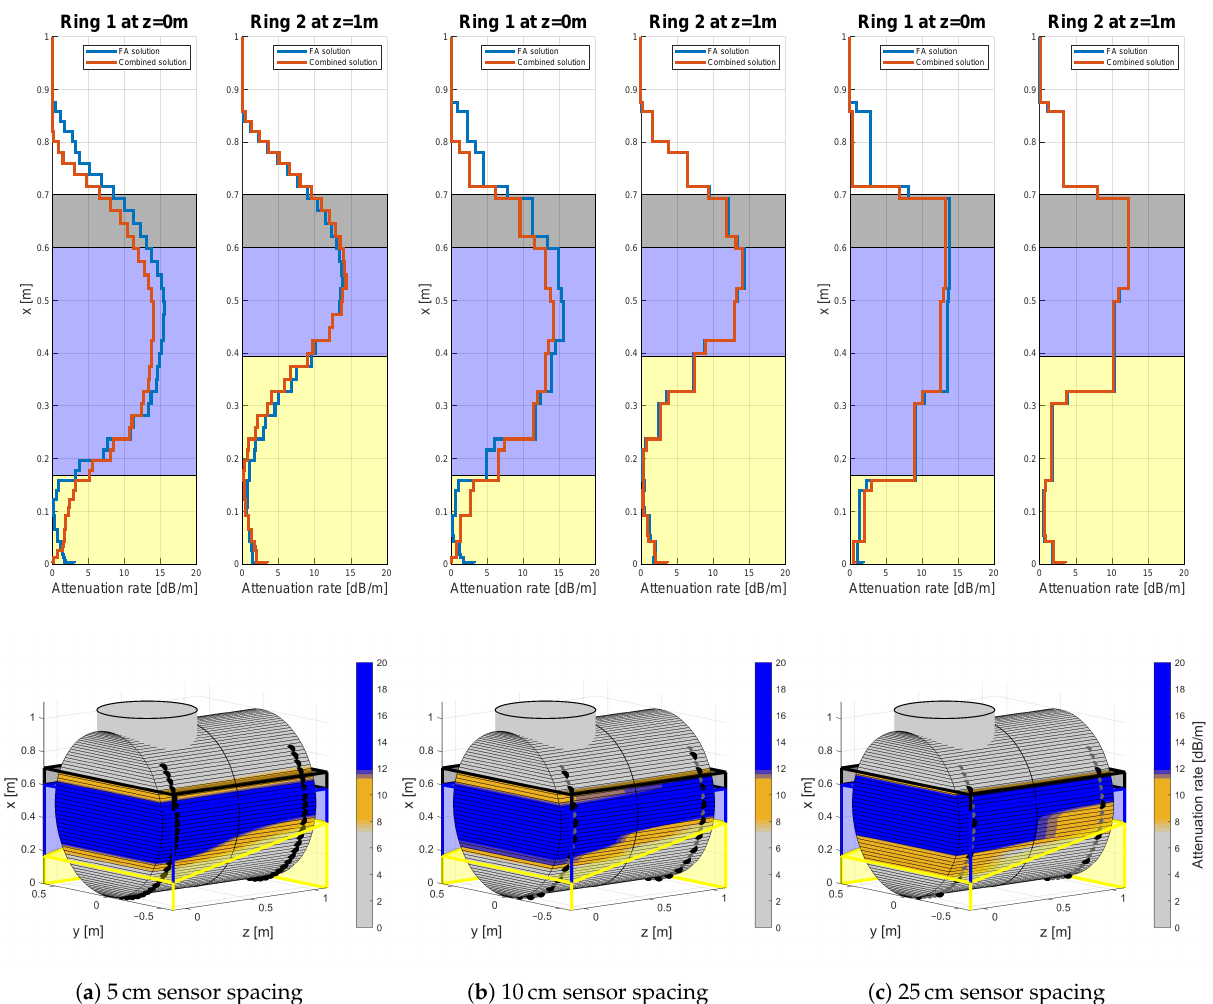
Figure 11. Results for three different equidistant sensor spacings, 10cm oil, 60cm water, a 15 ◦ sand slope and an excitation frequency of